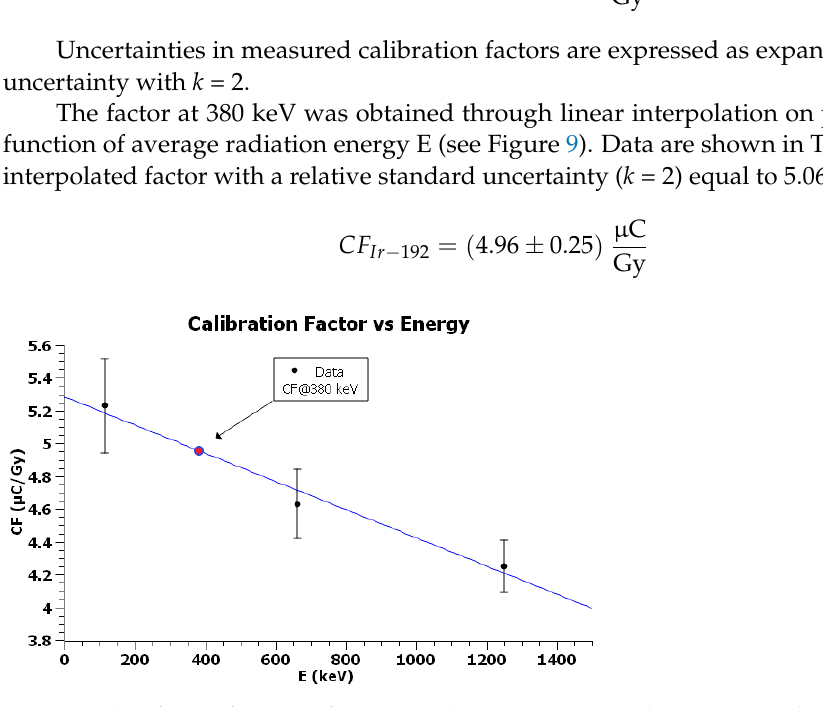
Figure 9. Plot of CF as function of average radiation energy. Error bars represent the total uncertainty (k = 2) for the TLD calibration measurements from Table 5. Table 5. Measured CFs for different average radiation energies with estimated expanded uncertainties ∆ CF